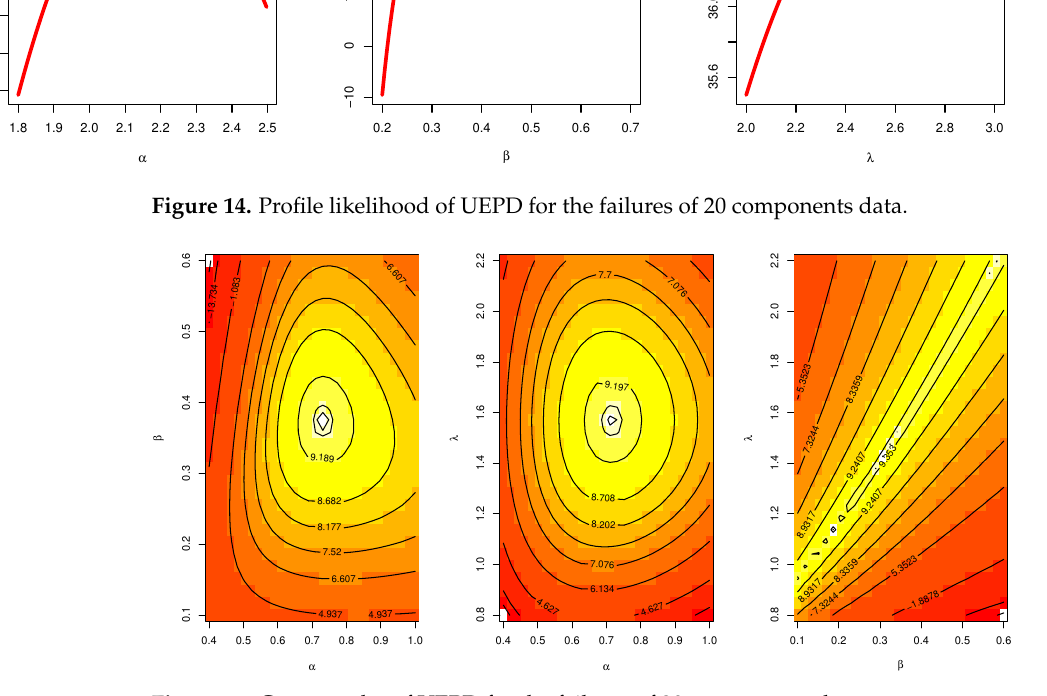
Figure 15. Contour plot of UEPD for the failures of 20 components